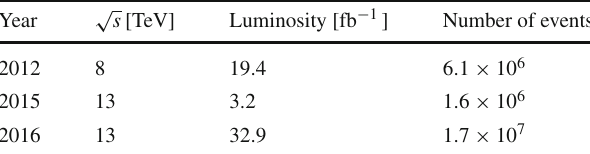
Table1 Thetotalintegratedluminosityandnumberof Z -taggedevents in the datasets used in this